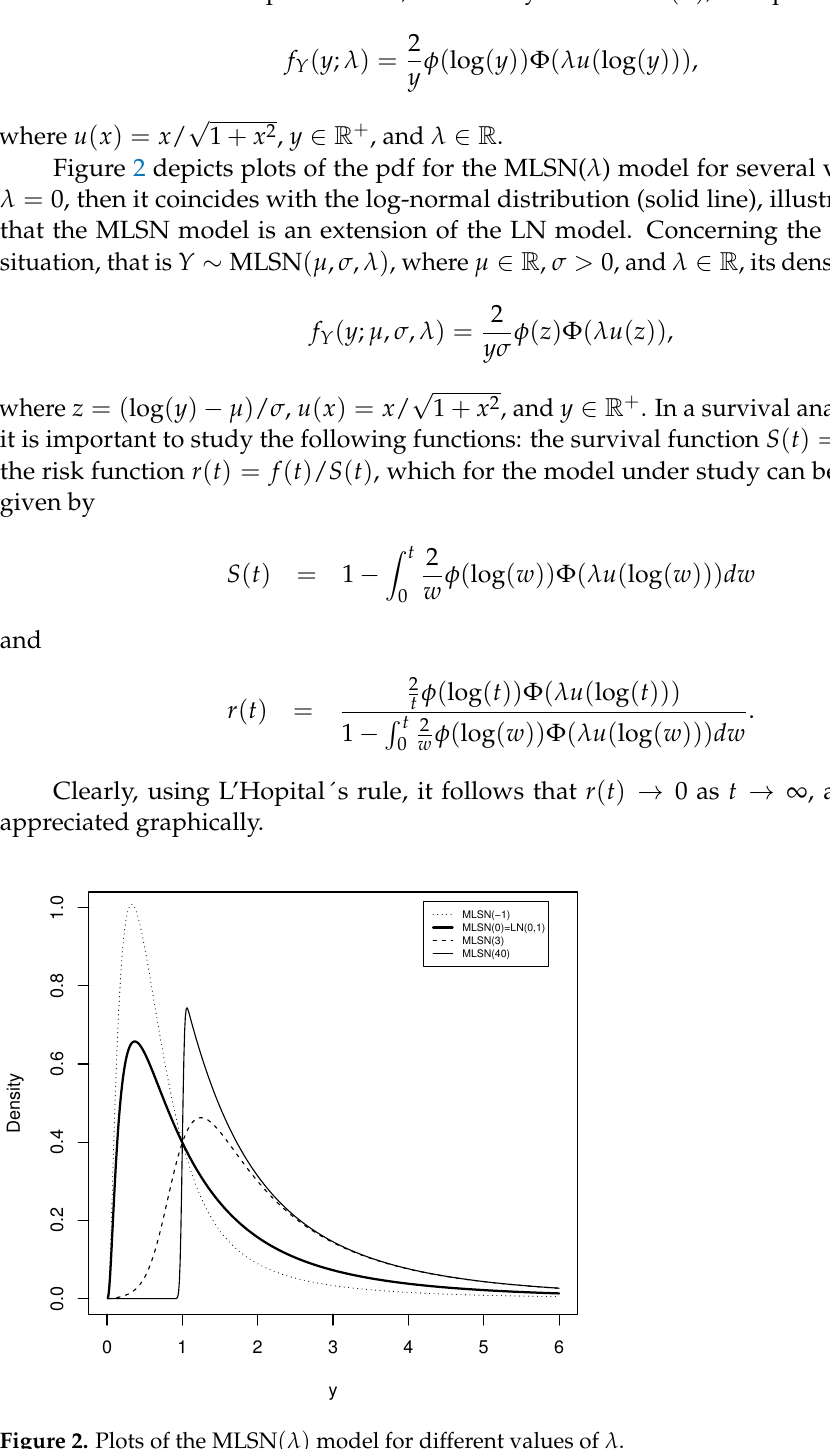
Figure 2. Plots of the MLSN ( λ ) model for different values of λ